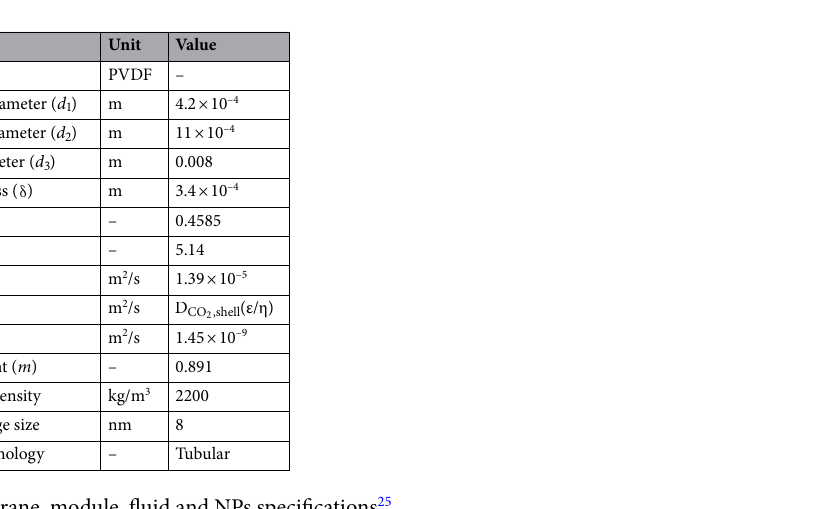
Table 3. Membrane, module, fluid and NPs specifications 25